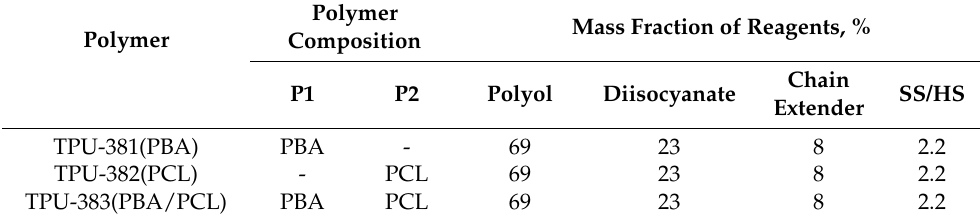
Table 1. Chemical composition of